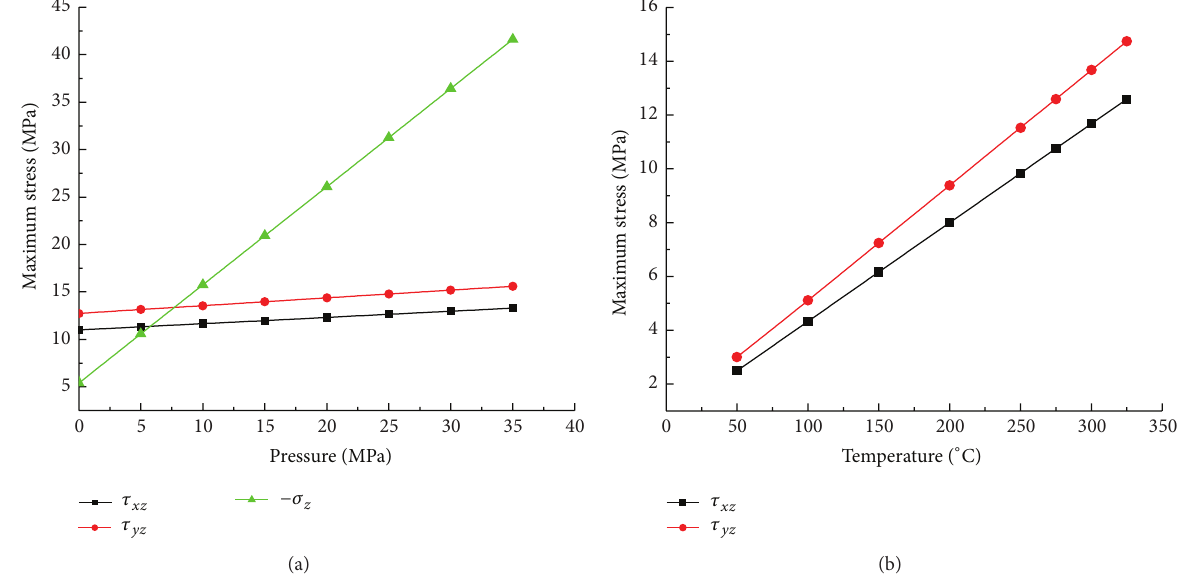
Figure 5: The impact of (a) pressure on the maximum shear/peel stress; and (b) temperature on the maximum shear stress.